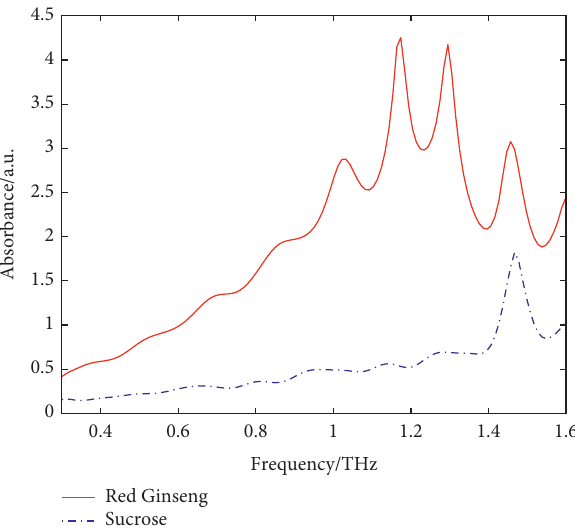
Figure 3: The average absorbance spectra of red ginseng and